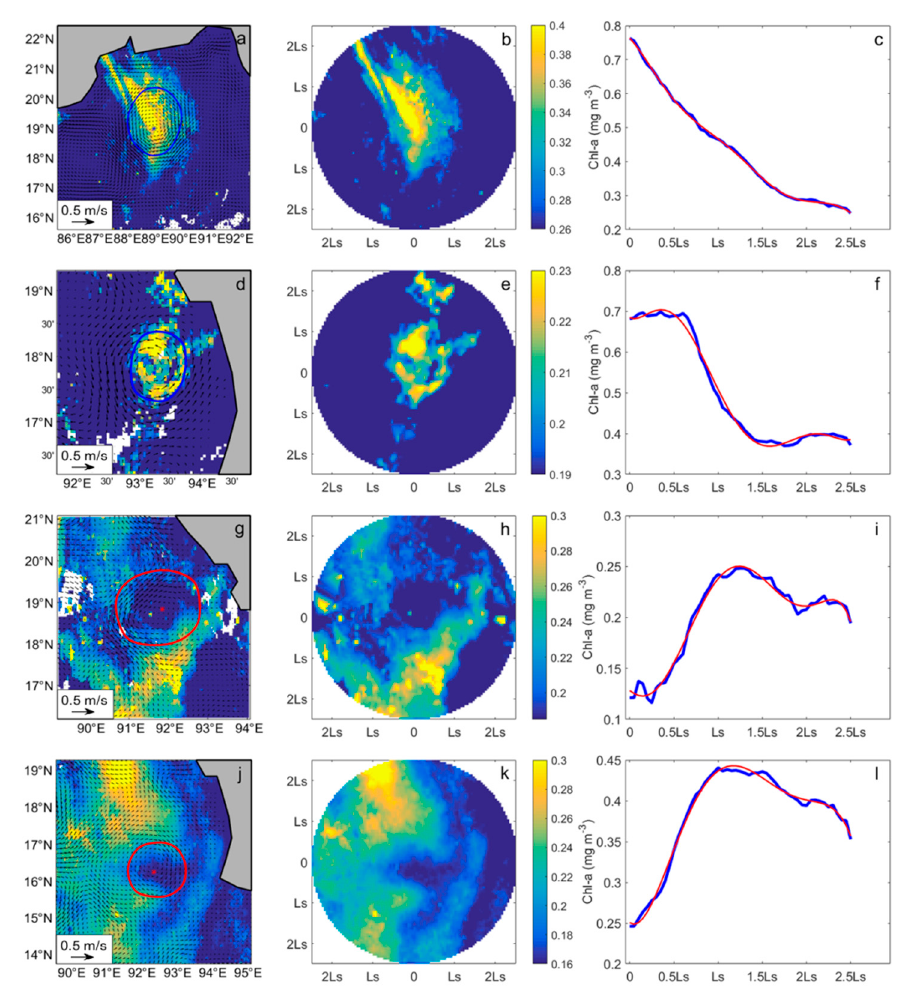
Figure 17. Schematic diagram of abnormal chlorophyll (Chl) eddies. CE is represented by ( a–f ), and AE is represented by ( g–l ). ( a ) A CE matched with Chl concentration data. Vectors represent geostrophic velocities. ( b ) Chlorophyll region is transformed into polar coordinates. ( c ) Distribution of the averaged chlorophyll as a function of the eddy radius. The peak of averaged Chl concentration locates around Ls, which denotes the eddy radius. Rho refers to the normalized distance from the eddy center related to Ls. Among them, blue is Chl data, and red is Fourier fitting curve. ( d–f ), ( g–i ), ( j–l ) have the same meaning as ( a–c ).